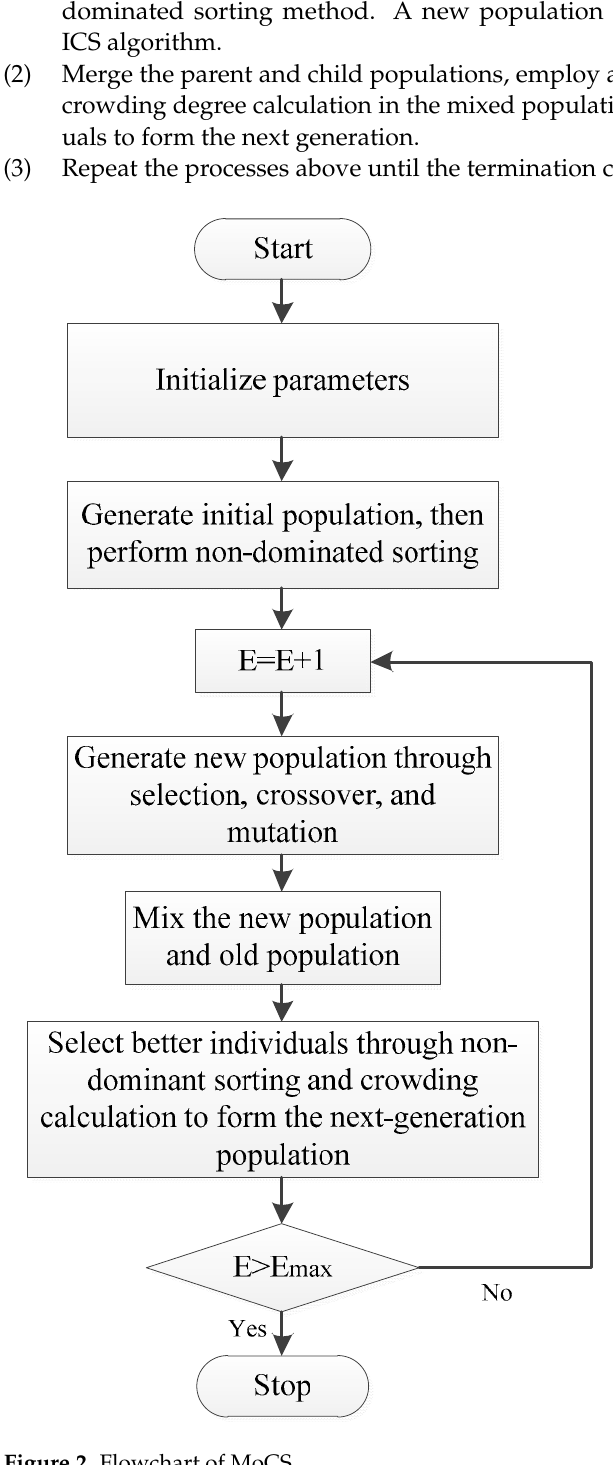
Figure 2. Flowchart of MoCS.